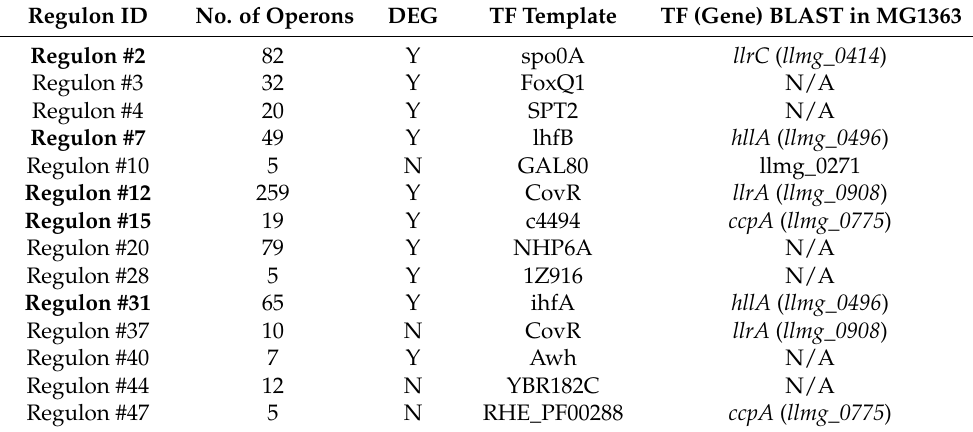
Table 1. Altogether, 14 significant regulons that are verified and mapped to known transcription factors (TFs). According to analyses, operon numbers and DEG determination (yes or no), matched template TFs and mapped TFs were assigned for each significant regulon, respectively, and were aligned based on regulon ID number. Five regulons containing DEGs and having the corresponding TF at the same time were bolded, being computationally verified as the regulons responsible for acid stress in